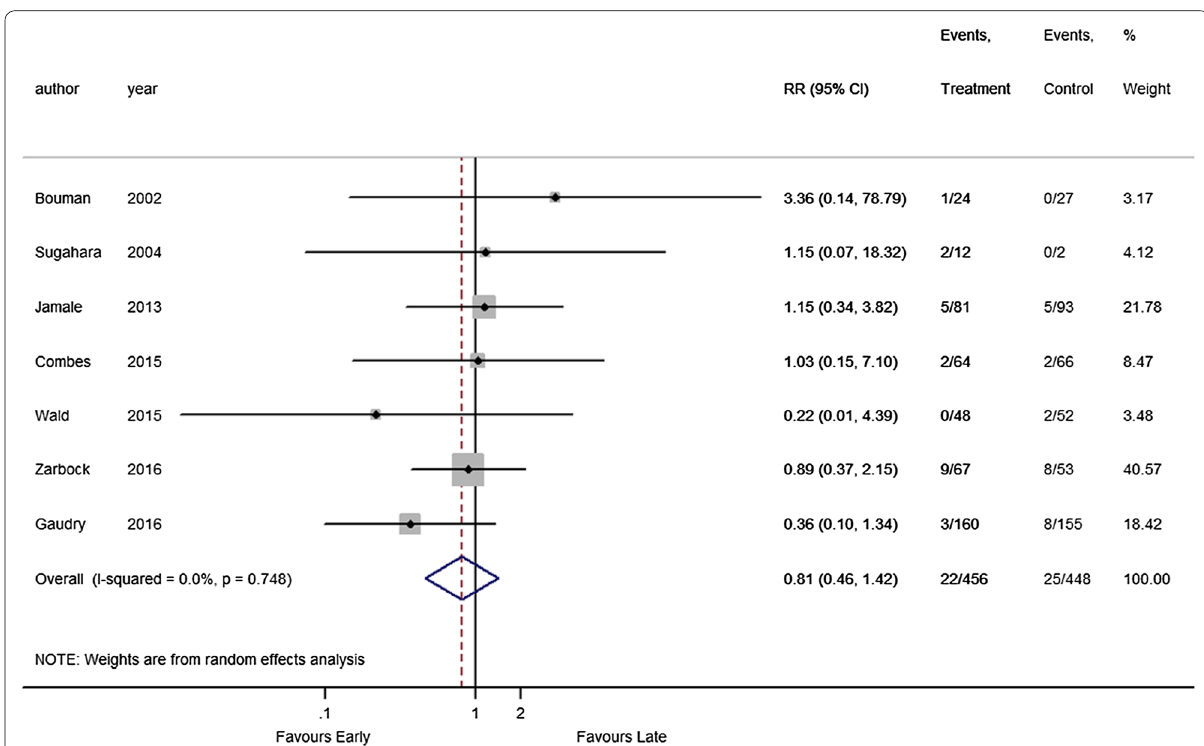
Fig. 5 Forest plot for RRT dependence: all studies. RCT randomized controlled trials, RRT renal replacement